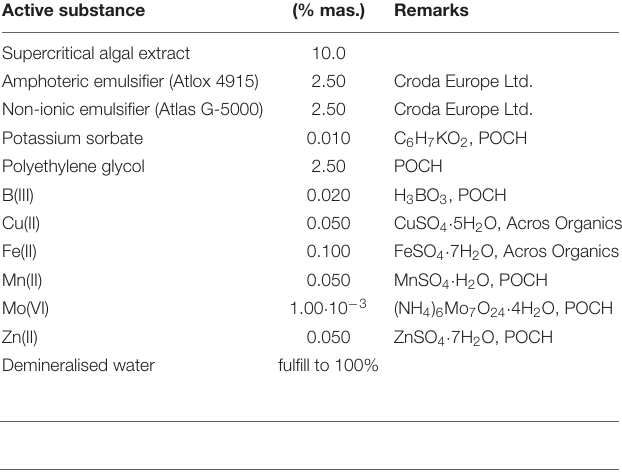
TABLE 2 | The composition of formulations designed for field trial containing supercritical extracts of S. platensis , Baltic macroalgae, and A. nodosum.